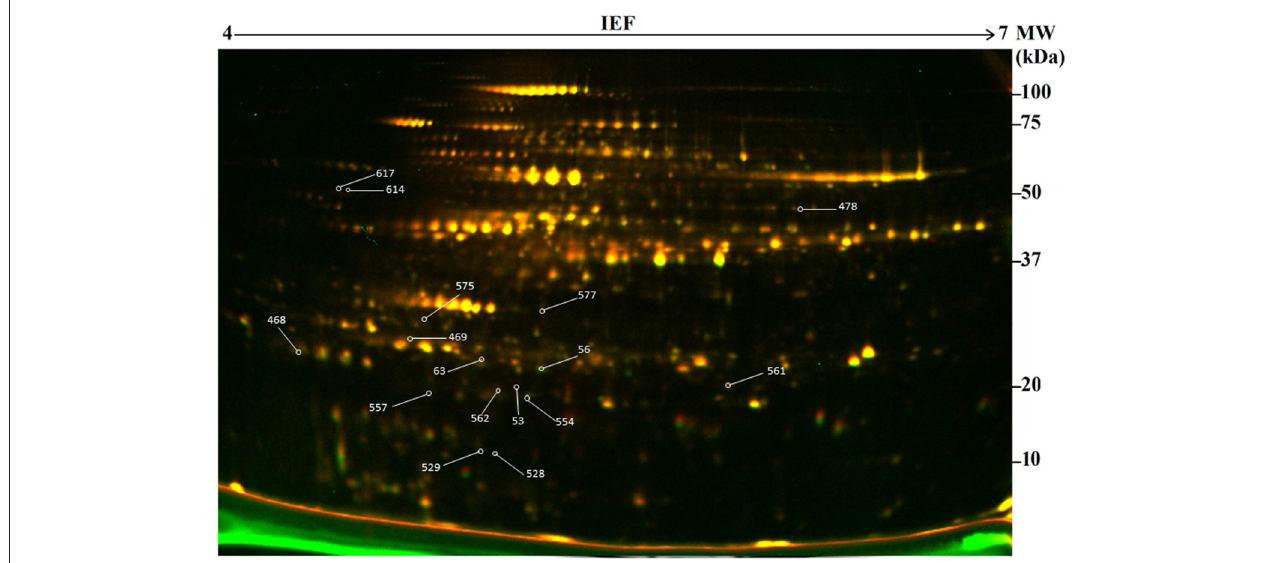
FIGURE 3 | Representative two-dimensional difference gel electrophoresis (2-D DIGE) map of the proteome of genetically modified maize plants (MON810 event) between pH 4 and 7. Delimited spots correspond to differentially expressed proteins selected for mass spectrometry identification. ID of identified proteins from Table 2 is indicated in yellow